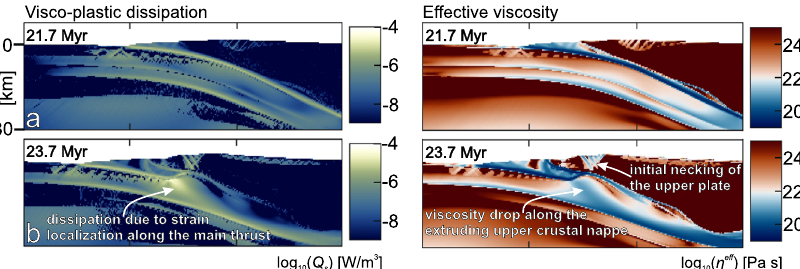
Fig. 5 The effect of shear heating. a Plot of visco-plastic dissipation of mechanical energy in the form of heat ( Q s ; left panel) and effective viscosity ( η eff , right panel) at the 21.6 Myr snapshot of the reference model, prior to nappe formation in the subducting continental crust. b Plots of visco-plastic dissipation of mechanical energy in the form of heat (left panel) and effective viscosity (right panel) at the 23.7 Myr snapshot of the reference model, after nappe formation at in the subducted continental crust. Color fi lls of the plots are based on scienti fi c colormaps 58